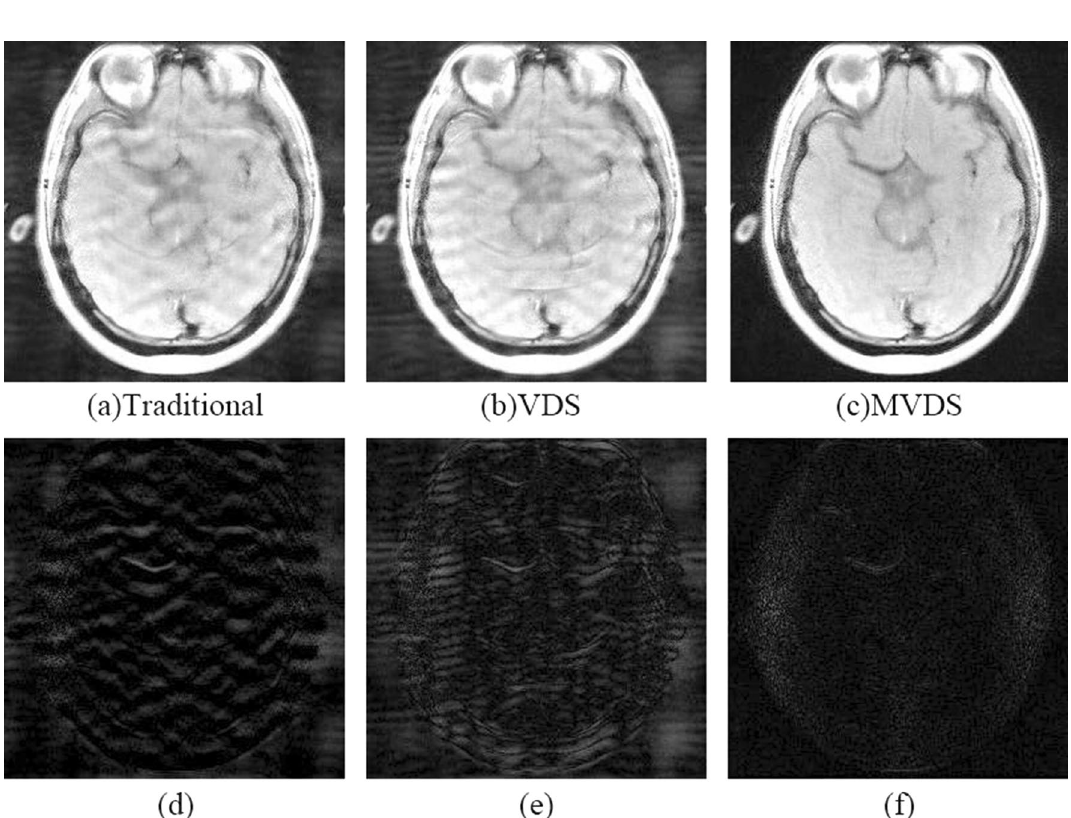
Figure 4. When R = 4 and ACS = 20, use NL-GRAPPA to reconstruct the image to compare traditional, VDS and MVDS method. ( a ) The traditional method, and ( d ) is the difference map. ( b ) The VDS method, and ( e ) is the corresponding difference map. ( c ) The MVDS method, sampling 20 lines of data with ORF = 2, and ( f ) is the difference graph. The kernel sizes are 15 × 2.